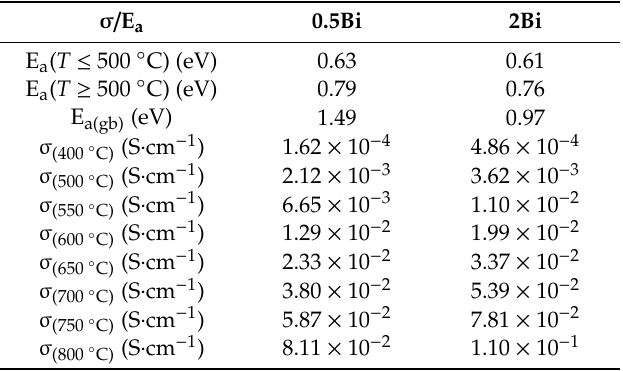
Table 3. Total conductivities ( σ ) and activation energies (E a ).